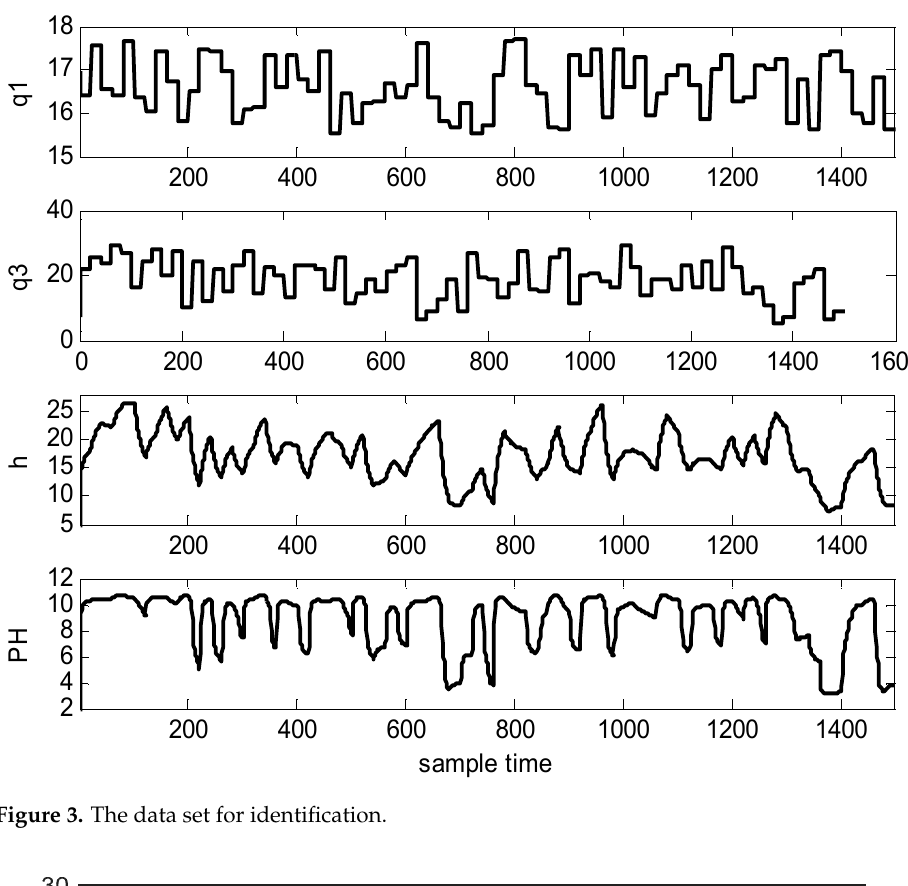
Figure 3. The data set for identification.